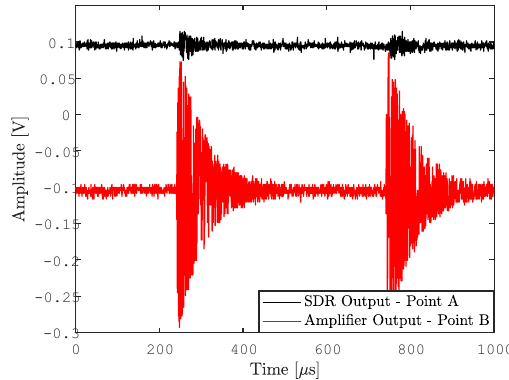
FIGURE 5. Output voltages taken at points A and B, respectively SDR and amplifier outputs. Note: Artificial DC offsets of ± 0.1V were added to ease the visualization of both